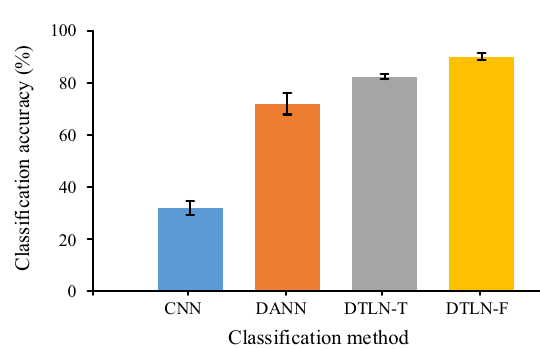
Fig. 9 Classification accuracy of average tenfold cross validation on the transfer experiments from C 1 (source domain) to A1 (target domain)